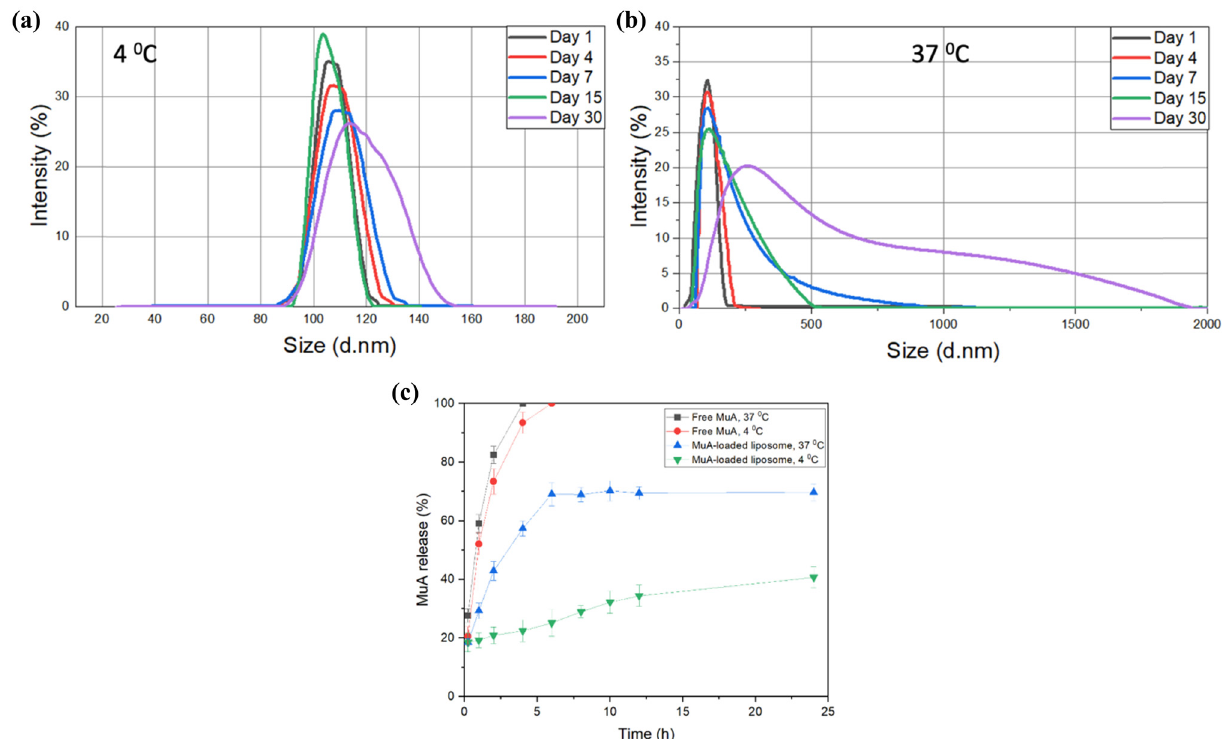
Figure 3: MuA - loaded liposome characterization. ( a ) Change of liposome size distribution at 4°C and ( b ) room temperature after 30 days; ( c ) in vitro release pro fi le of free MuA and MuA - loaded liposomes at 4 and 37°C obtained by the dialysis method. Data are presented as mean ± SD ( n = 3 ) .